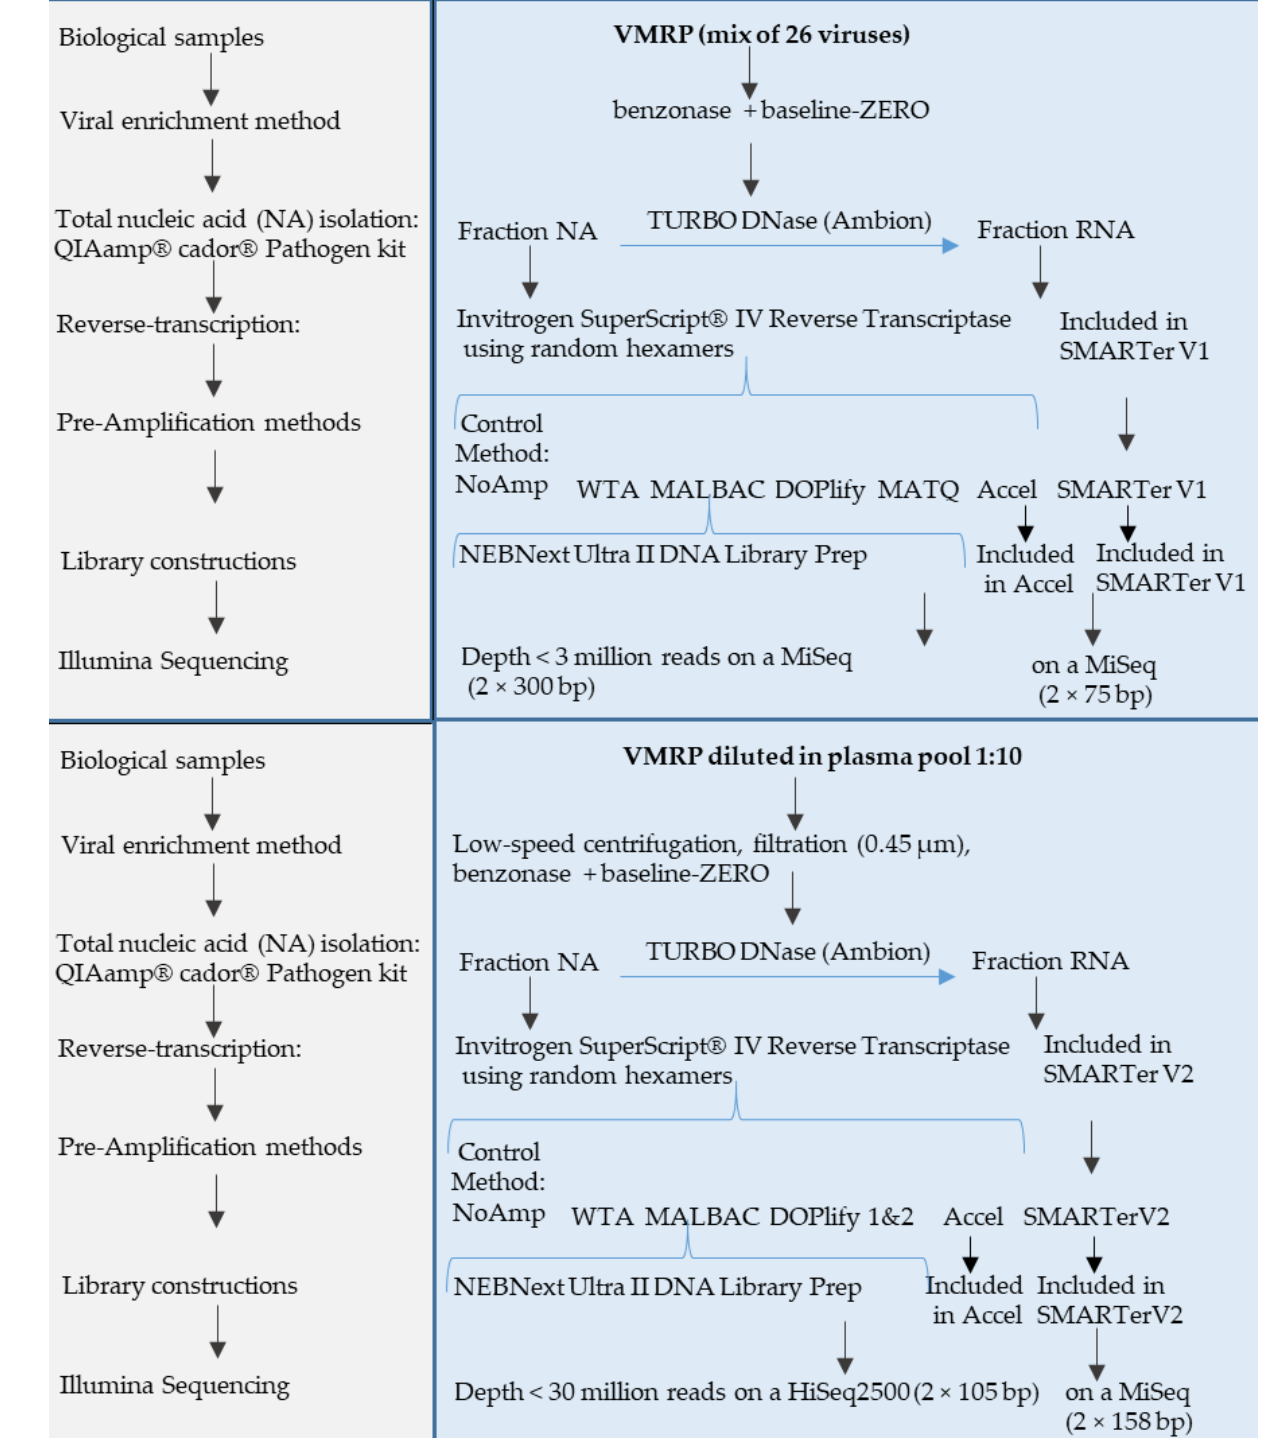
Figure 1. Experimental design with Virus Multiplex Reference Panel (VMRP). Six protocols including reverse transcription step, random pre-amplification step and subsequent library constructions were compared to a protocol without pre- amplification (NoAmp). A first experiment was carried out directly on a mix of 26 viruses representative of the diversity of viruses (VMRP) and the second experiment on VMRP diluted in a plasma matrix (ratio: 1/10). Both fractions, total nucleic acid fraction (NA) and RNA only, were